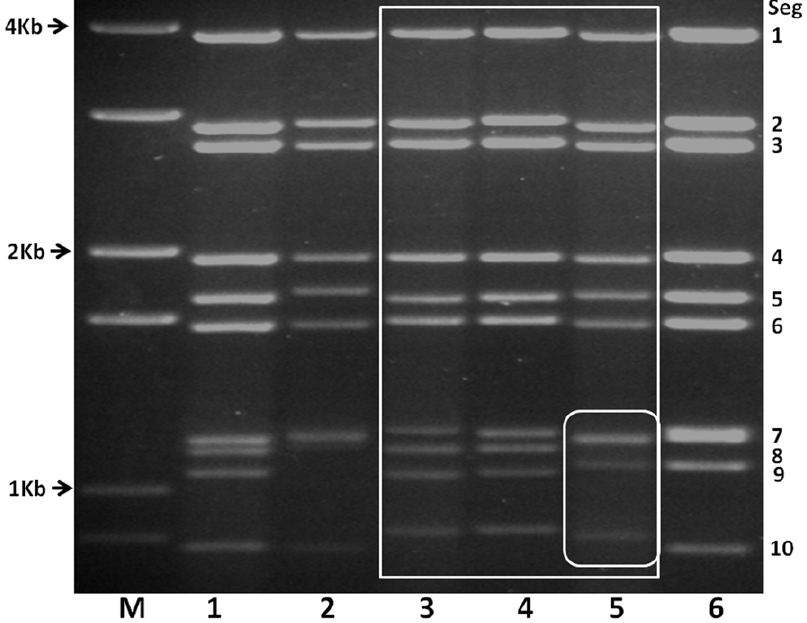
Figure 1. Agarose gel (1%) electrophoretic profile of the dsRNAs of Eubenangee (EUBV), Tilligerry (TILV) and Pata viruses (PATAV) along with those of BTV and EHDV. Lane M=100 bp Marker; 1=BTV-1w (LIB2007/07); 2=EHDV-6w (USA2006/05); 3=EUBV (AUS1963/01); 4=TILV (AUS1978/03); 5=PATAV (CAF1968/01); 6=EHDV-8e (AUS1982/05).